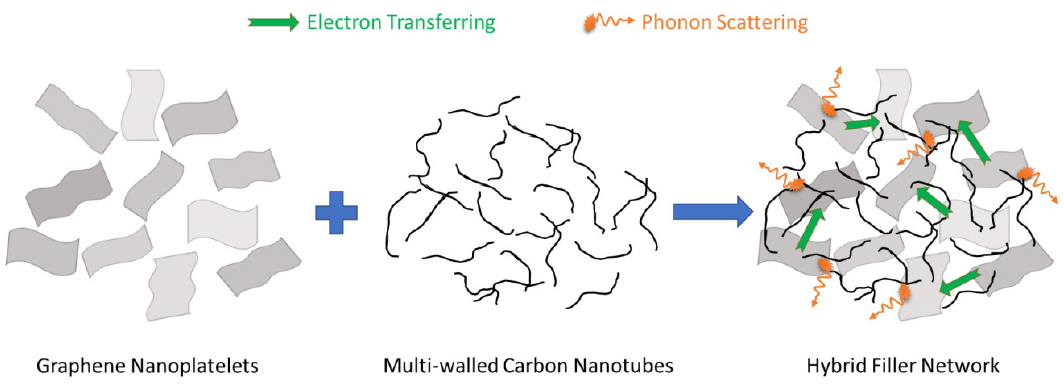
Figure 7. The synergistic effects of 1D and 2D conducting nanoparticles on electron and phonon transferring through their 3D networks.